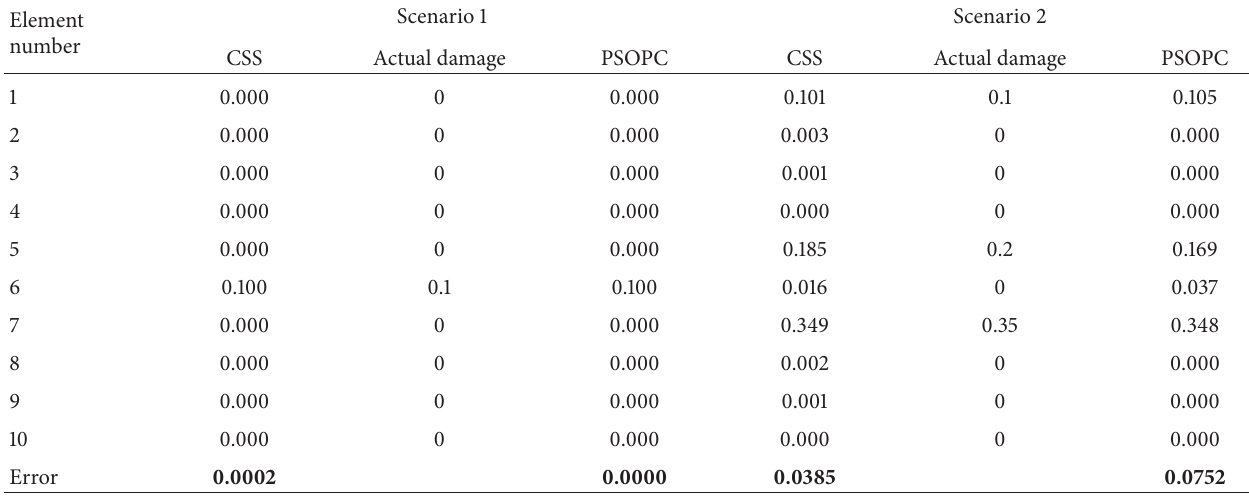
Table 2: Results of damage detection of the 10-element beam using CSS and PSOPC algorithms.